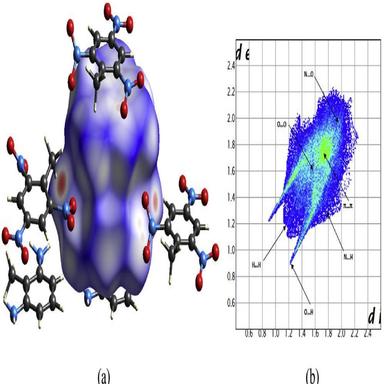
(a) Hirshfeld surface analysis of TNT-ATL, (b) the two-dimensional fingerprint plot of TNT-ATL.